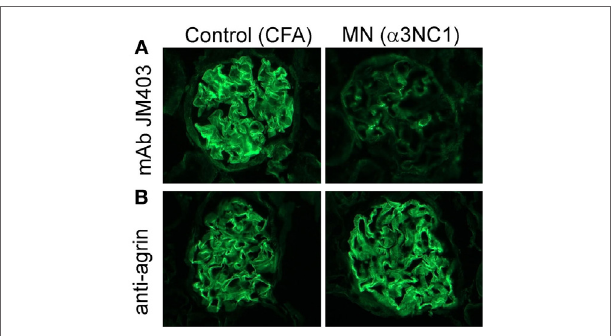
FigUre 10 | Decreased glomerular basement membrane (GBM) staining by anti-heparan sulfate mAb JM403 in experimental MN. (a) Immuno- fluorescence staining with anti-heparan sulfate mAb JM403 revealed intense staining in the GBM of control mice, which was markedly decreased in